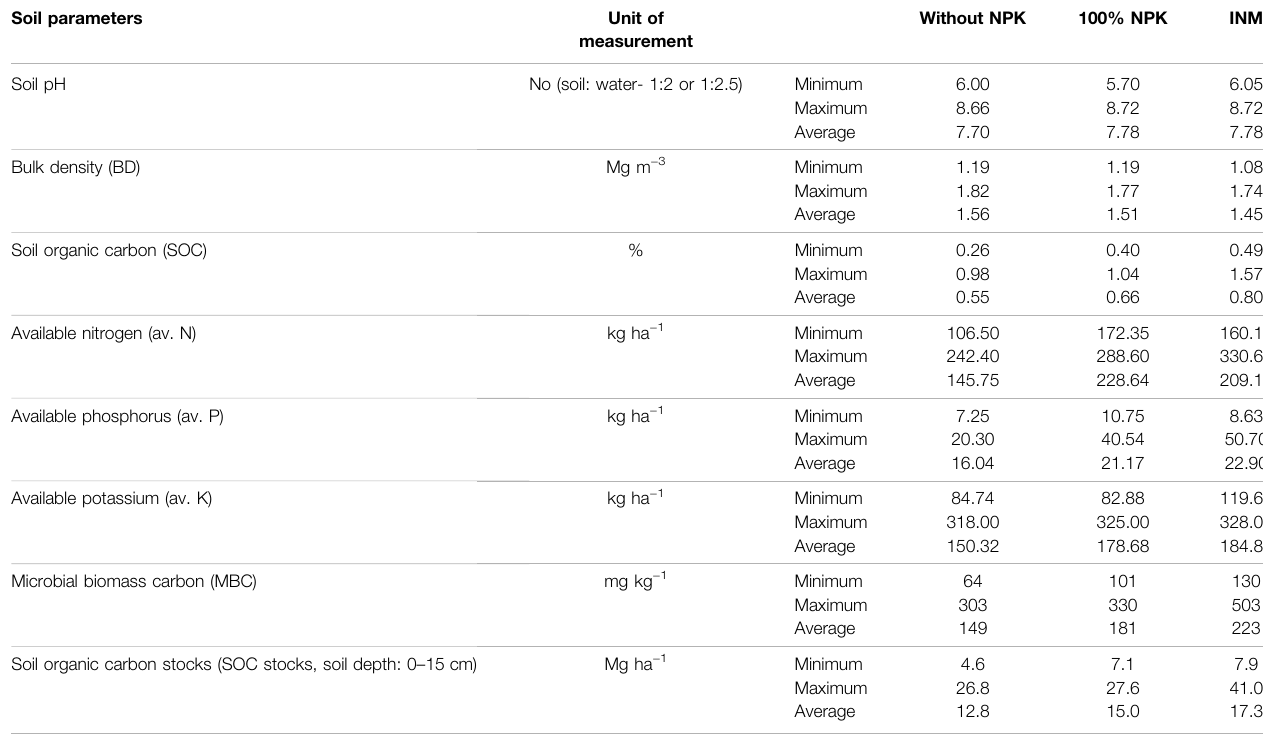
TABLE 2 | Physico-chemical and biological properties of studied sites in Indian soils. Soil